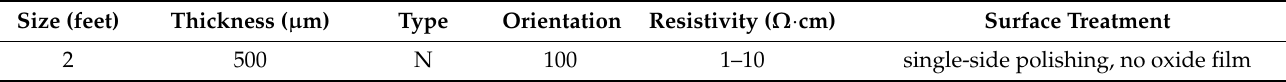
Table 1. The parameters of the silicon